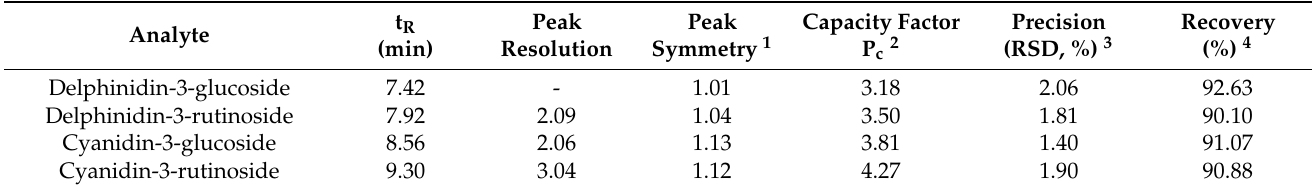
Table 1. Validation parameters of the HPLC-DAD method for separation of four major anthocyanins. Analyte